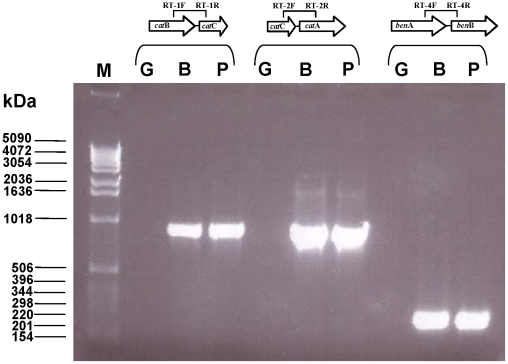
Results of RT-PCR.The PCR-products were amplified from cDNA template to prove the induction of the cat and ben genes in presence of glucose (G), benzoate (B) and phenol (P). catB/catC (881 bp); catC/catA (866 bp); benA/benB (197 bp).